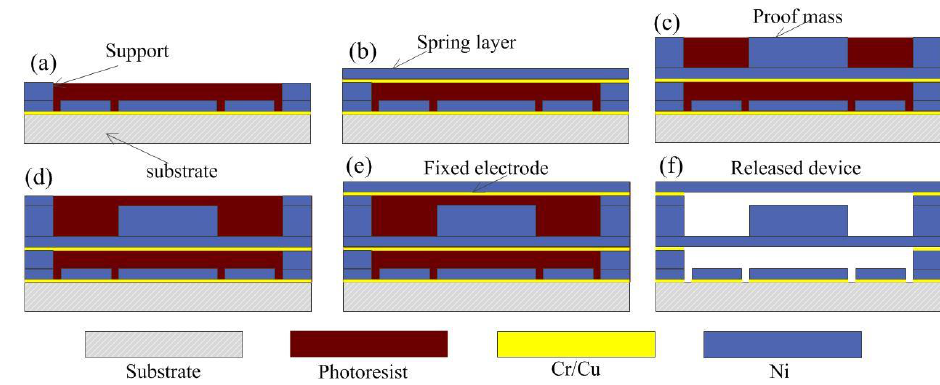
Figure 10. Schematic diagram of primary fabrication process.